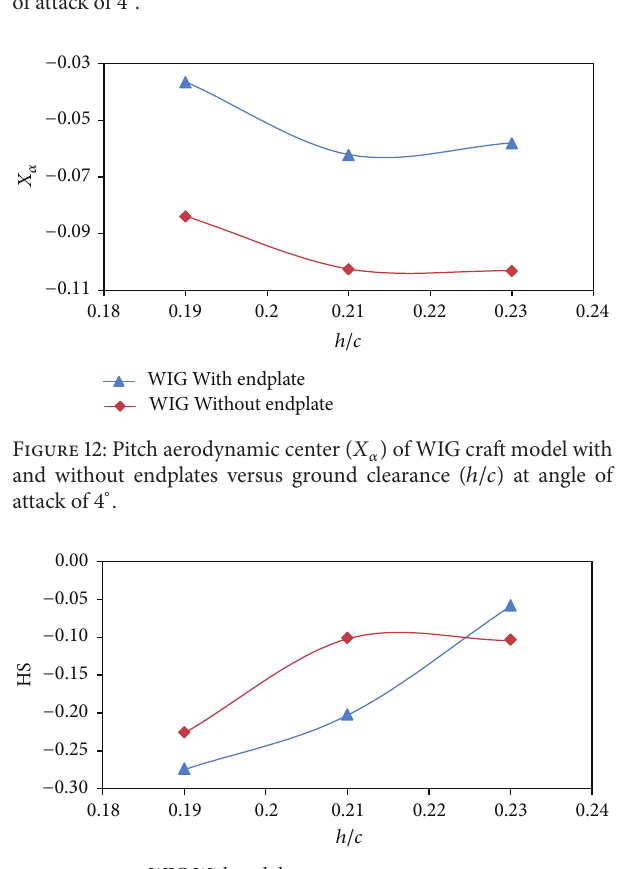
Figure 11: Height of aerodynamic center ( 𝑋 ℎ ) of WIG craft model with and without endplates versus ground clearance ( ℎ/𝑐 ) at angle of attack of 4 ∘ .